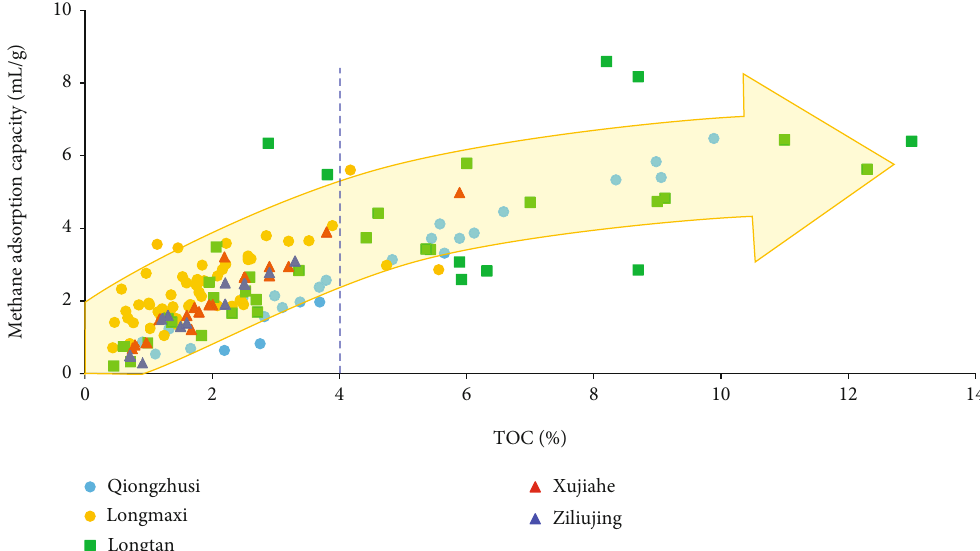
Figure 6: Relationship between methane adsorption capacity and TOC of di ff erent types of shale. With the increase of TOC content, methane adsorption capacity increases gradually. After TOC > 0 : 4 % , the increase range